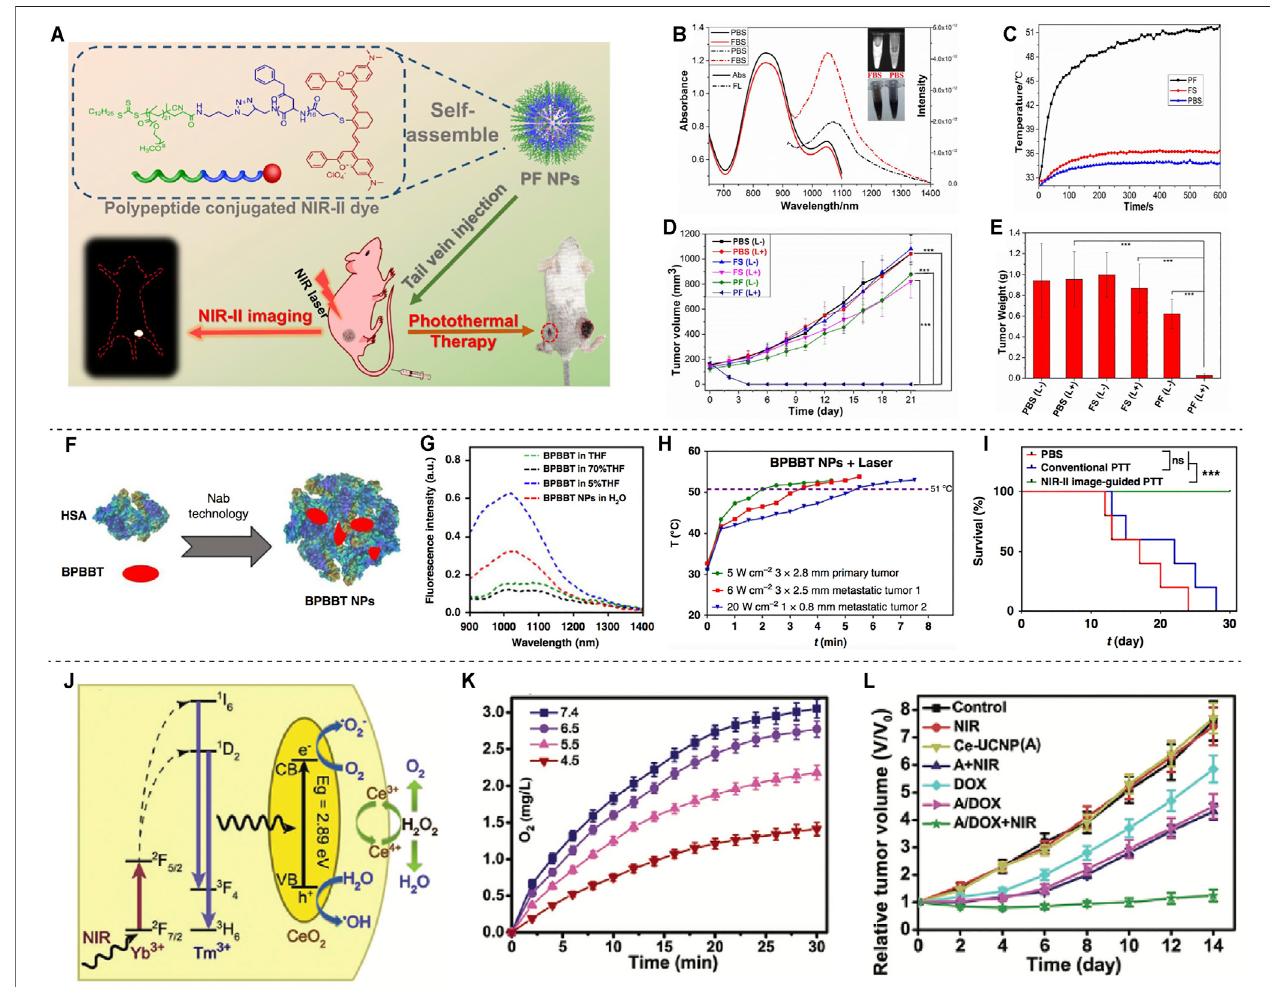
FIGURE 4 | NIR-II based PTT and PDT. (A) Schematic illustration of the NIR image-guided PTT by PF. (B) Absorption and fl uorescence emission spectra of PF in PBSand FBS. (C) Thetemperature pro fi leoftumorsafter injectionwithPFunderlaserirradiation. (D) Thetumor volume ofthemiceafter PTT. (E) Thetumorweightafter PTT (reproduce from (Li et al., 2019) with permission from American Chemical Society). (F) Schematic illustration of BPBBT NPs. (G) Fluorescence intensity of BPBBT NPs in water. (H) Temperature change curve of tumors after treatment with BPBBT NPs. (I) Survival curves of mice bearing colon cancer following different treatments(reproducedfrom (Gaoet al.,2019)withpermissionfromSpringerNature). (J) Schematic illustration ofthe mechanismofO 2 generation. (K) ProducingofO 2 by Ce-UCNPs catalysis in aqueous solution. (L) Tumor growth curves after various treatments (reproduced from (Yao et al., 2018) with permission from John Wiley and